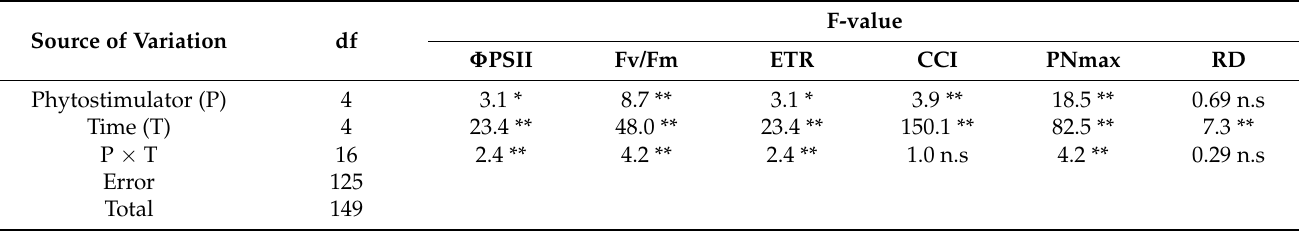
Table 1. Analysis of variance for the effect of phytostimulators and time of measuring. Df=degree of freedom, Φ PSII: effective quantum yield of photosystem II in the light, Fv/Fm: maximum photo- synthetic efficiency of PSII, ETR: electron transport rate, CCI: chlorophyll content index, P N max: asymptote of photosynthesis at high PAR, RD: dark respiration